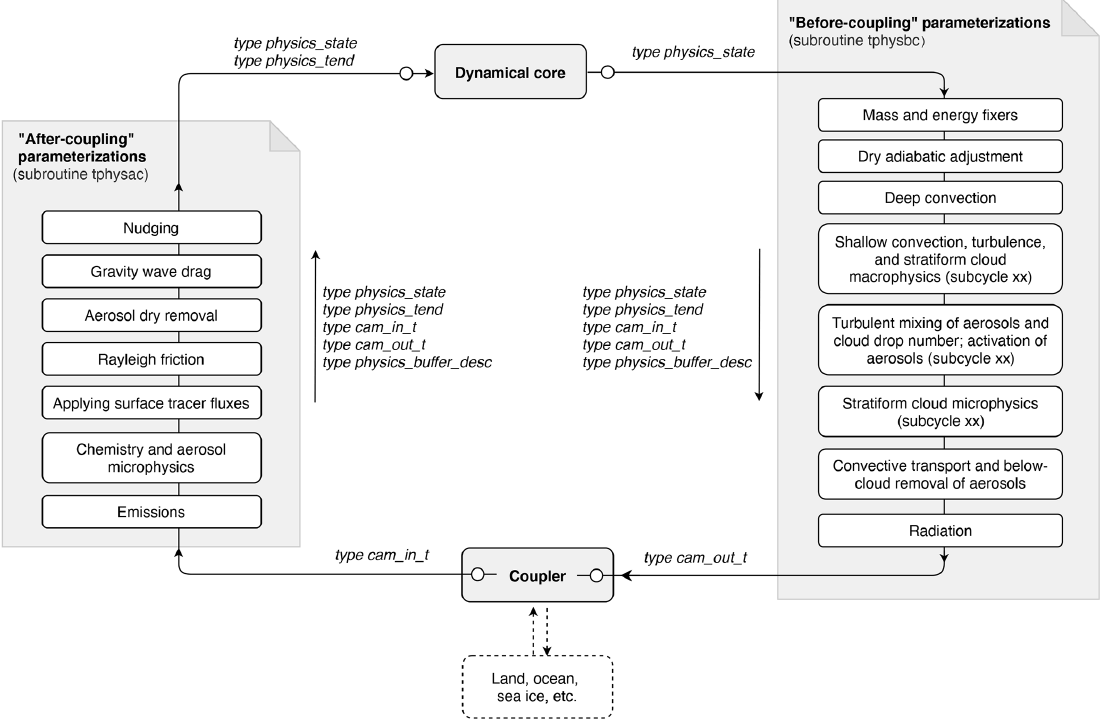
Figure 1. A schematic showing the four compartments (gray boxes) of the EAMv1 code: the dynamical core, the coupler, and two groups of parameterizations calculated before or after the communication with the coupler. The derived data types used for passing information among these compartments and within the two groups of parameterizations are shown in italics. The two small circles shown next to the dynamical core and the two circles placed inside the coupler box represent transfer of information to or from data structures internal to the dynamical core or the coupler. The white boxes with solid outlines shown in the “before-coupling” and “after-coupling” parameterization groups are examples (not complete lists) of parameterizations and numerical treatments included in typical EAM